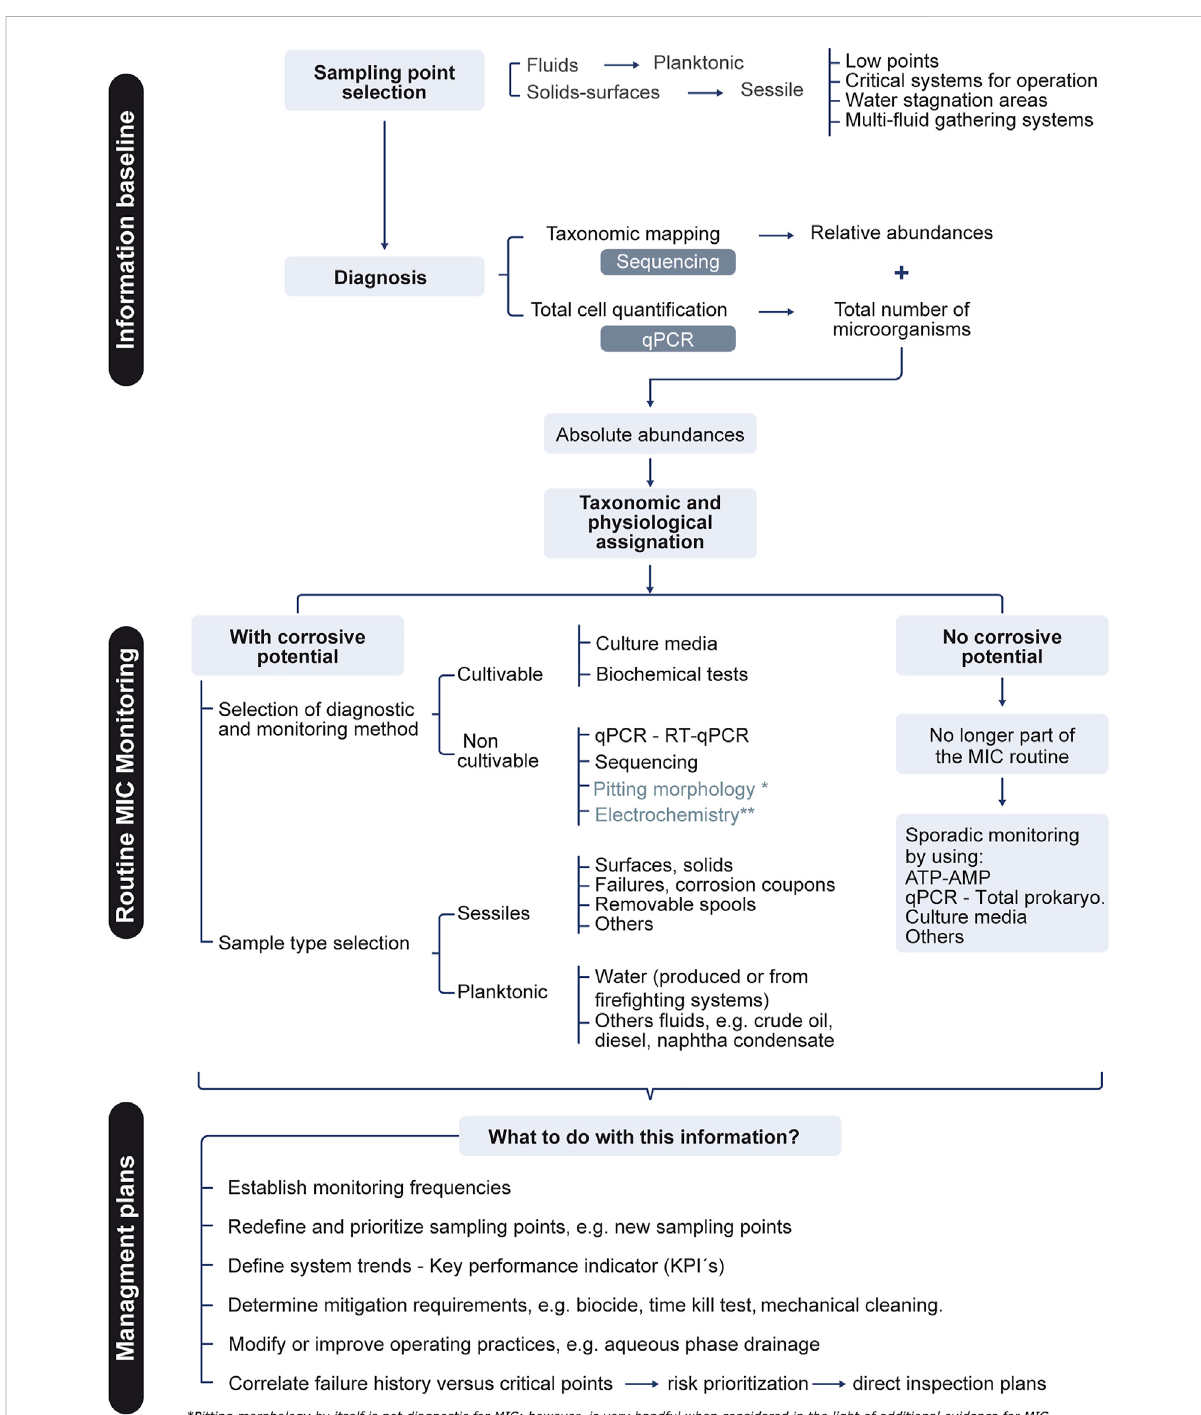
FIGURE 3 Suggested roadmap for fi eld MIC